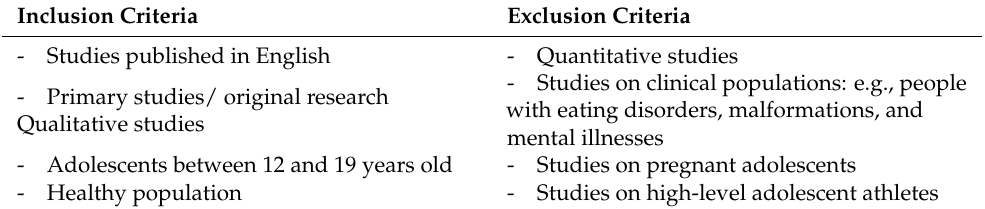
Table 1. Eligibility criteria.